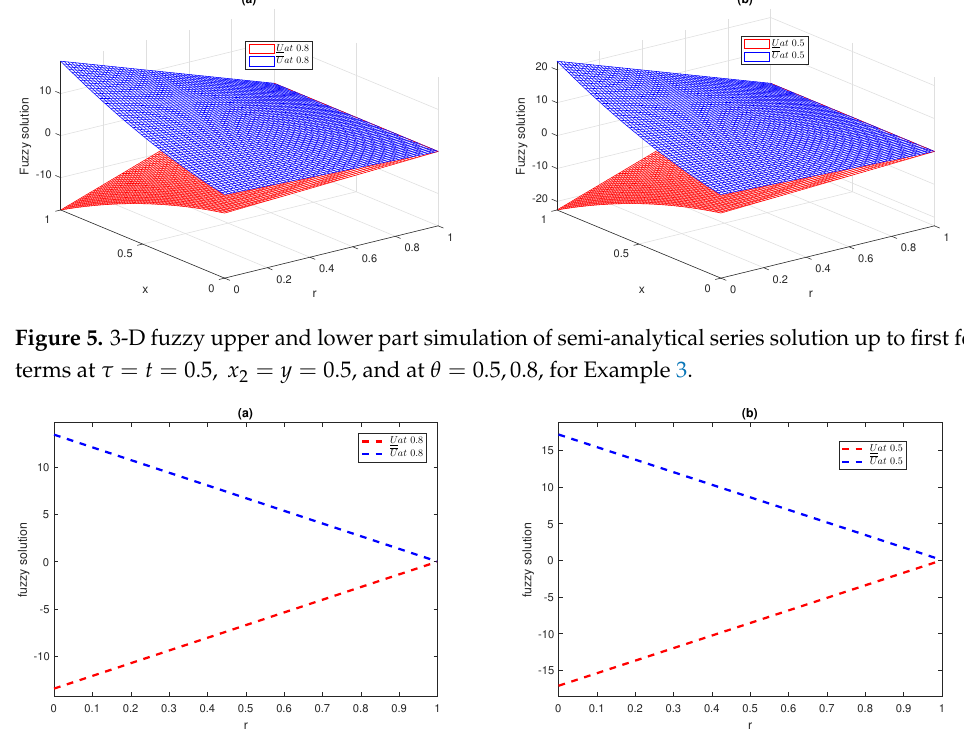
Figure 6. 2-D fuzzy upper and lower part simulation of semi-analytical series solution up to first four terms at x 1 = x = 0.8, τ = t = 0.5, x 2 = y = 0.5, and for different non-integer orders of Example